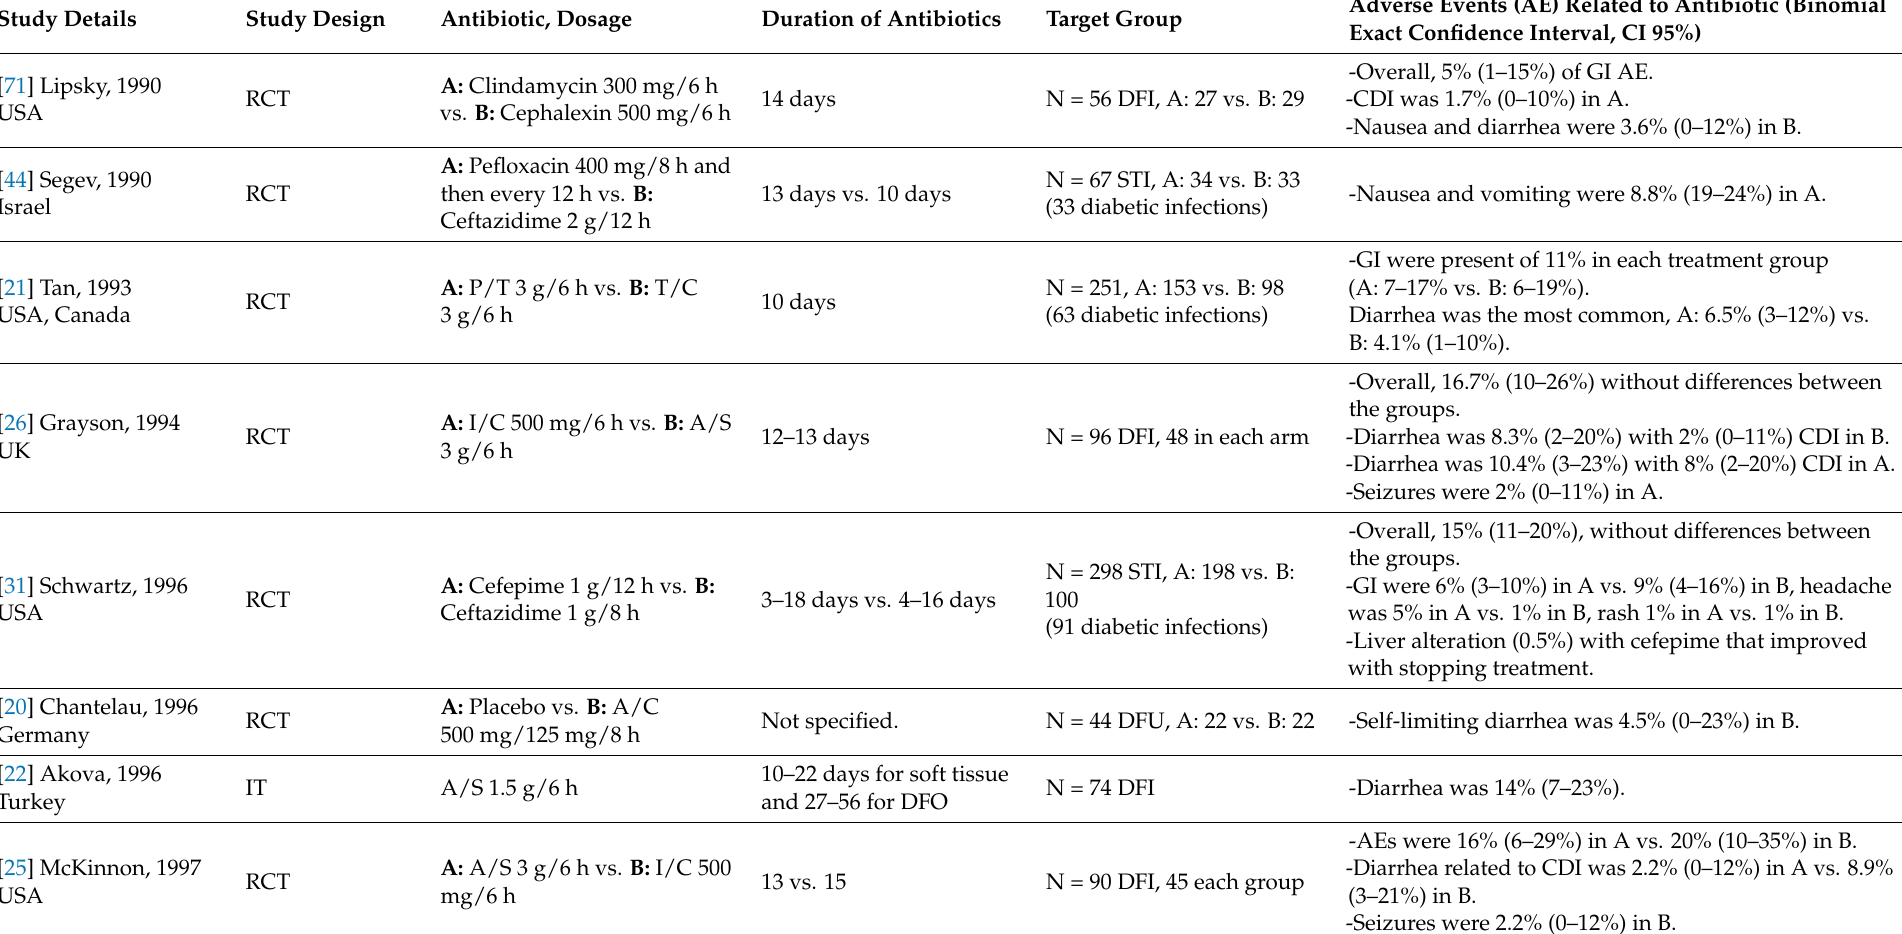
Table 1. Adverse events related to the use of antibiotics in diabetic foot infections (soft tissue, osteomyelitis, and wound